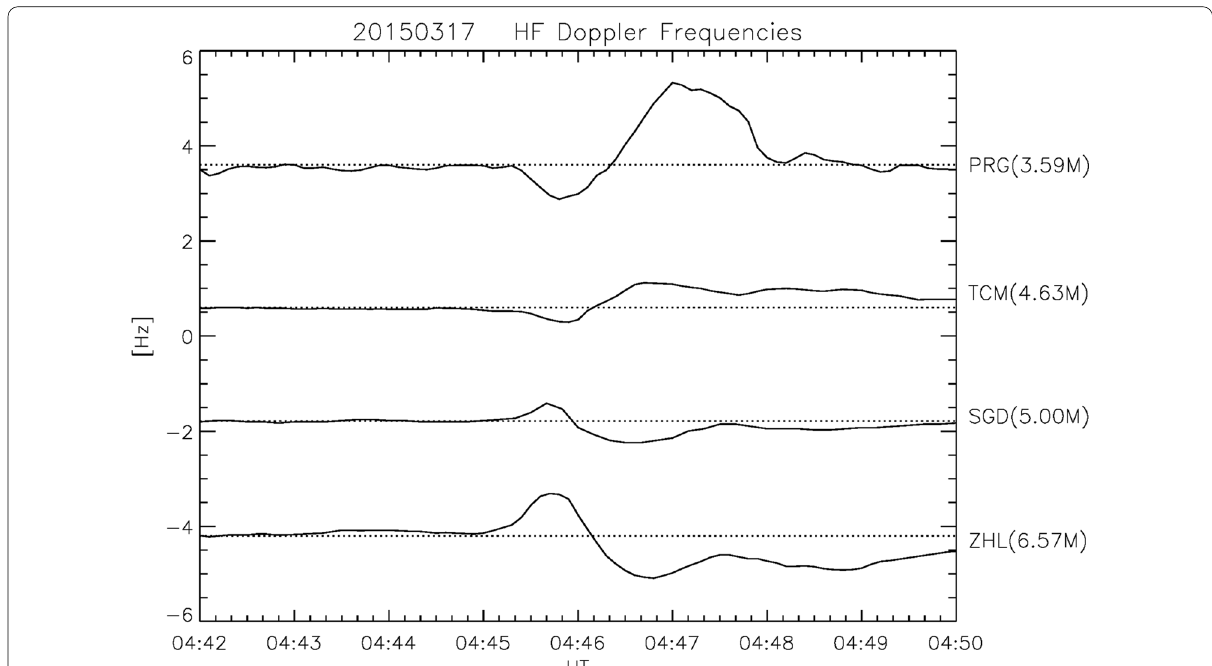
Fig. 2 HF Doppler frequencies observed during the SC at Prague (PRG, 3.59 MHz) and Tucuman (TCM, 4.63 MHz) on the nightside (0545, 0025 MLT) and at Sugadaira (SGD, 5.006 MHz) and Zhongli (ZHL, 6.57 MHz) on the dayside (1345, 1250 MLT). The HF Doppler frequencies are composed of the negative PFD and positive MFD on the nightside, and vice versa on the dayside